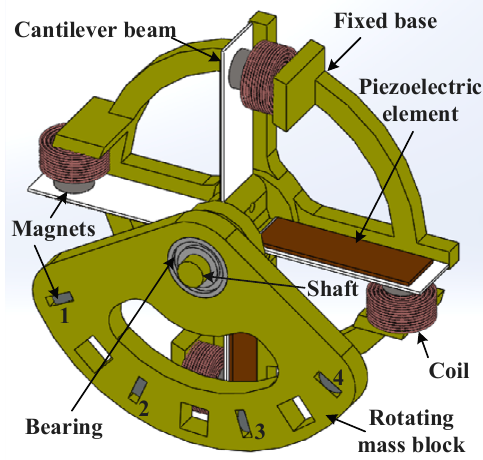
Figure 1. The structural design of the multi-directional vibration energy harvester.